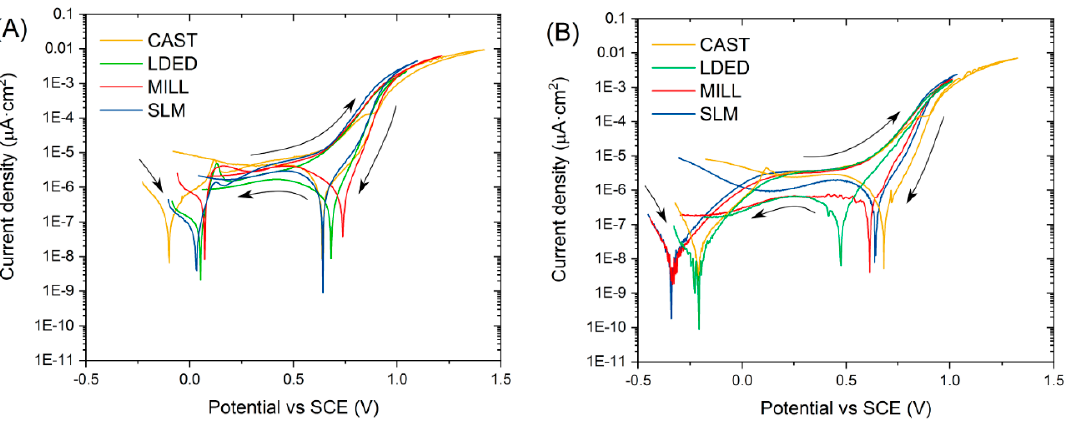
Figure 9. Representative cyclic potentiodynamic polarization curves of the different manufacturing techniques in aerated ( A ) and deaerated ( B ) artificial saliva (AS). Table 6. Summary of the results of the cyclic potentiodynamic polarization (CPCD) tests . Electrolytic